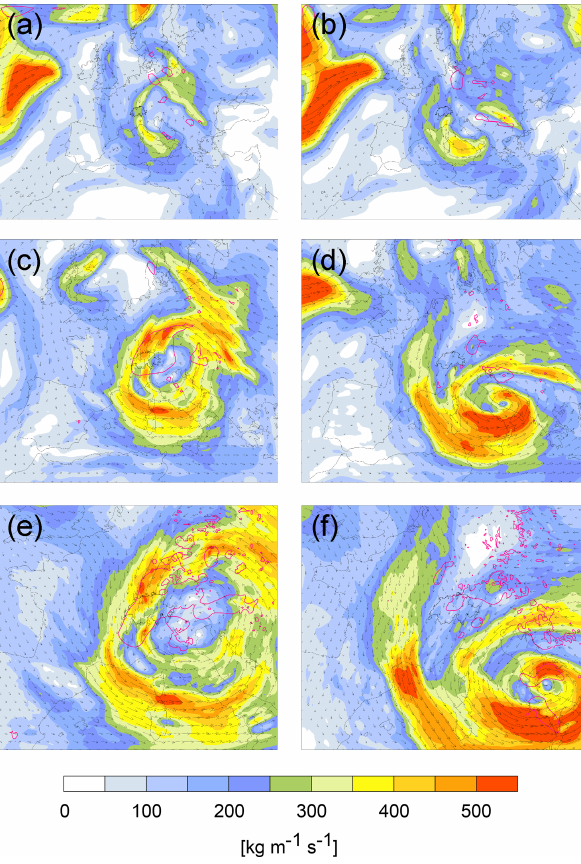
Figure 7. As in Fig. 6, but for 14 June 1910 18:00UTC, and for different maximum (#54) and minimum (#43)